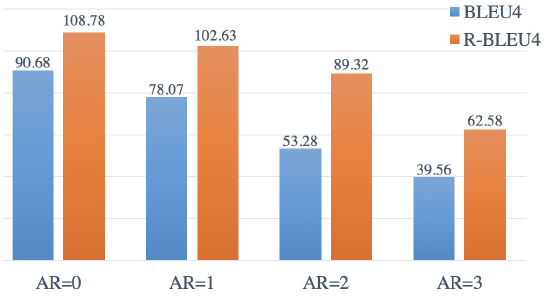
Figure 4. BLUE4 score and R-BLEU4 score of the utterances with different accumulate